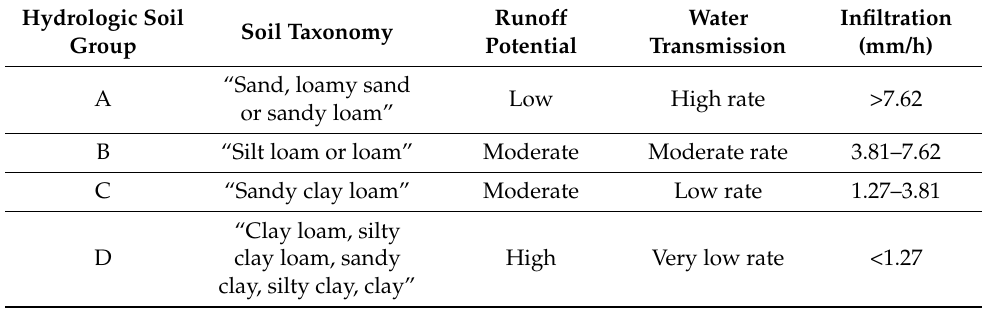
Table 1. Natural resource conservation service classification